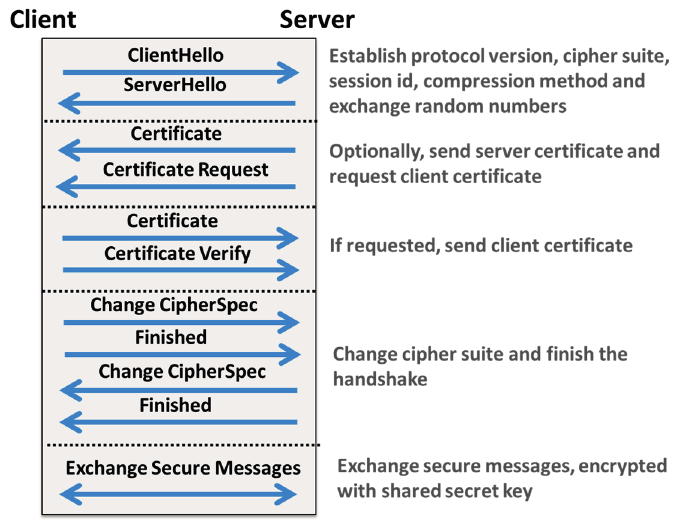
Figure 6. Overview of the Transport Layer Security (TLS)